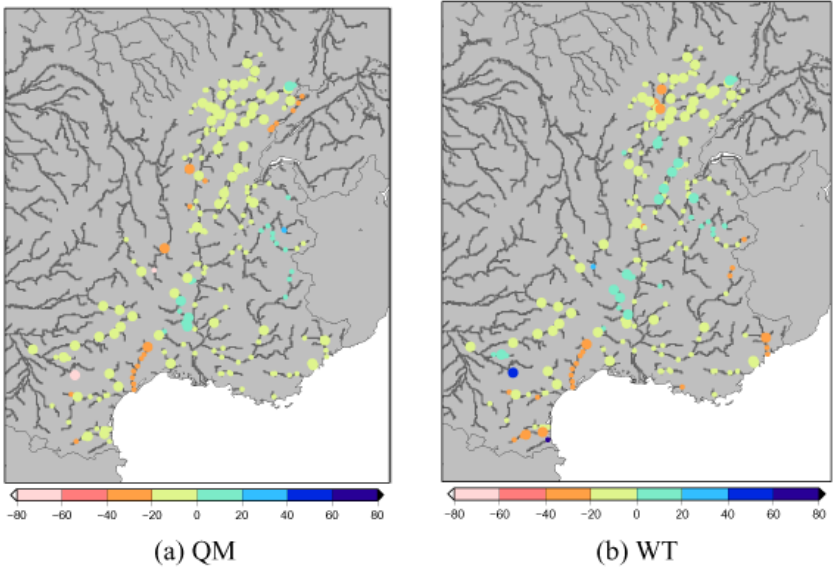
Fig. 11. Difference between the QMNA5 calculated with the two simulations forced by downscaling methods and the simulation forced by SAFRAN/F (in %) for the period